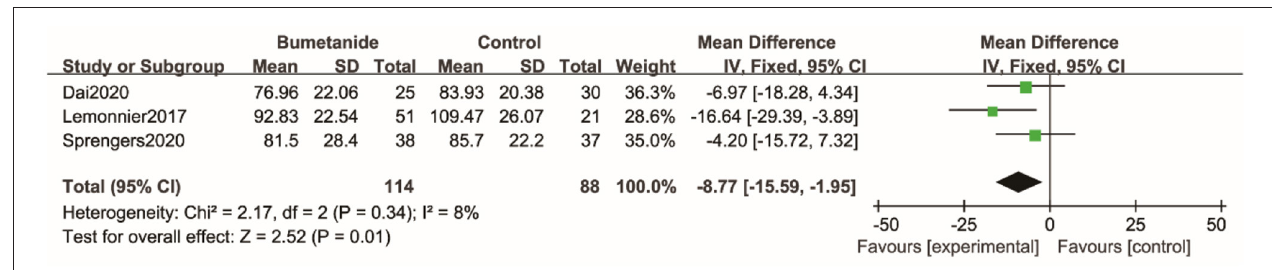
FIGURE 4 | Forest plot of the efficacy of bumetanide on SRS in children with ASD.